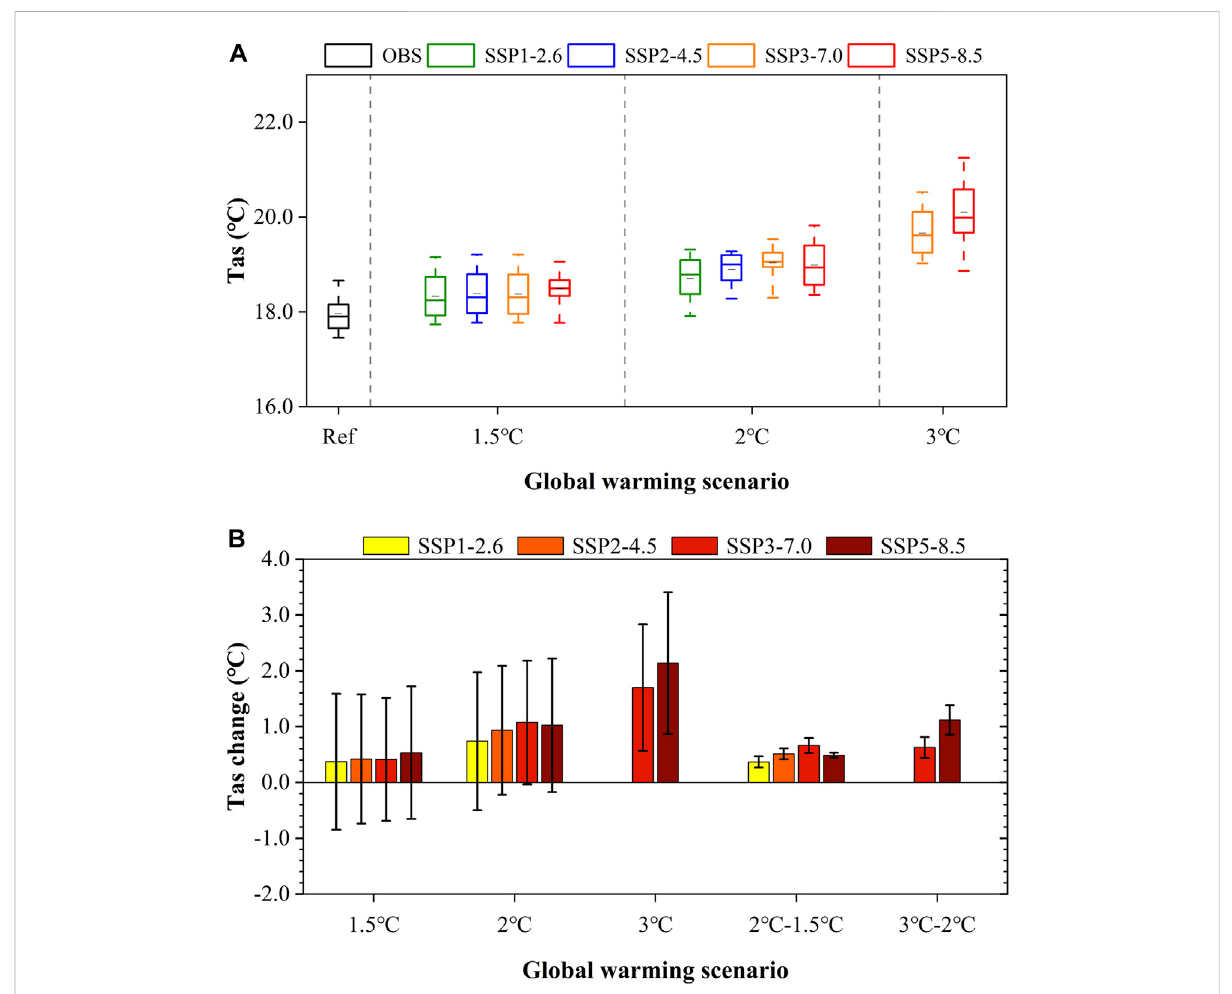
FIGURE 7 Boxplot diagram of Tas change under different scenarios (A) and the error bar plot of Tas change relative to the reference period (B) in the PLB. Refer denotes the reference period (1986 – 2005). The black vertical line indicates the standard deviation of 17 CMIP6